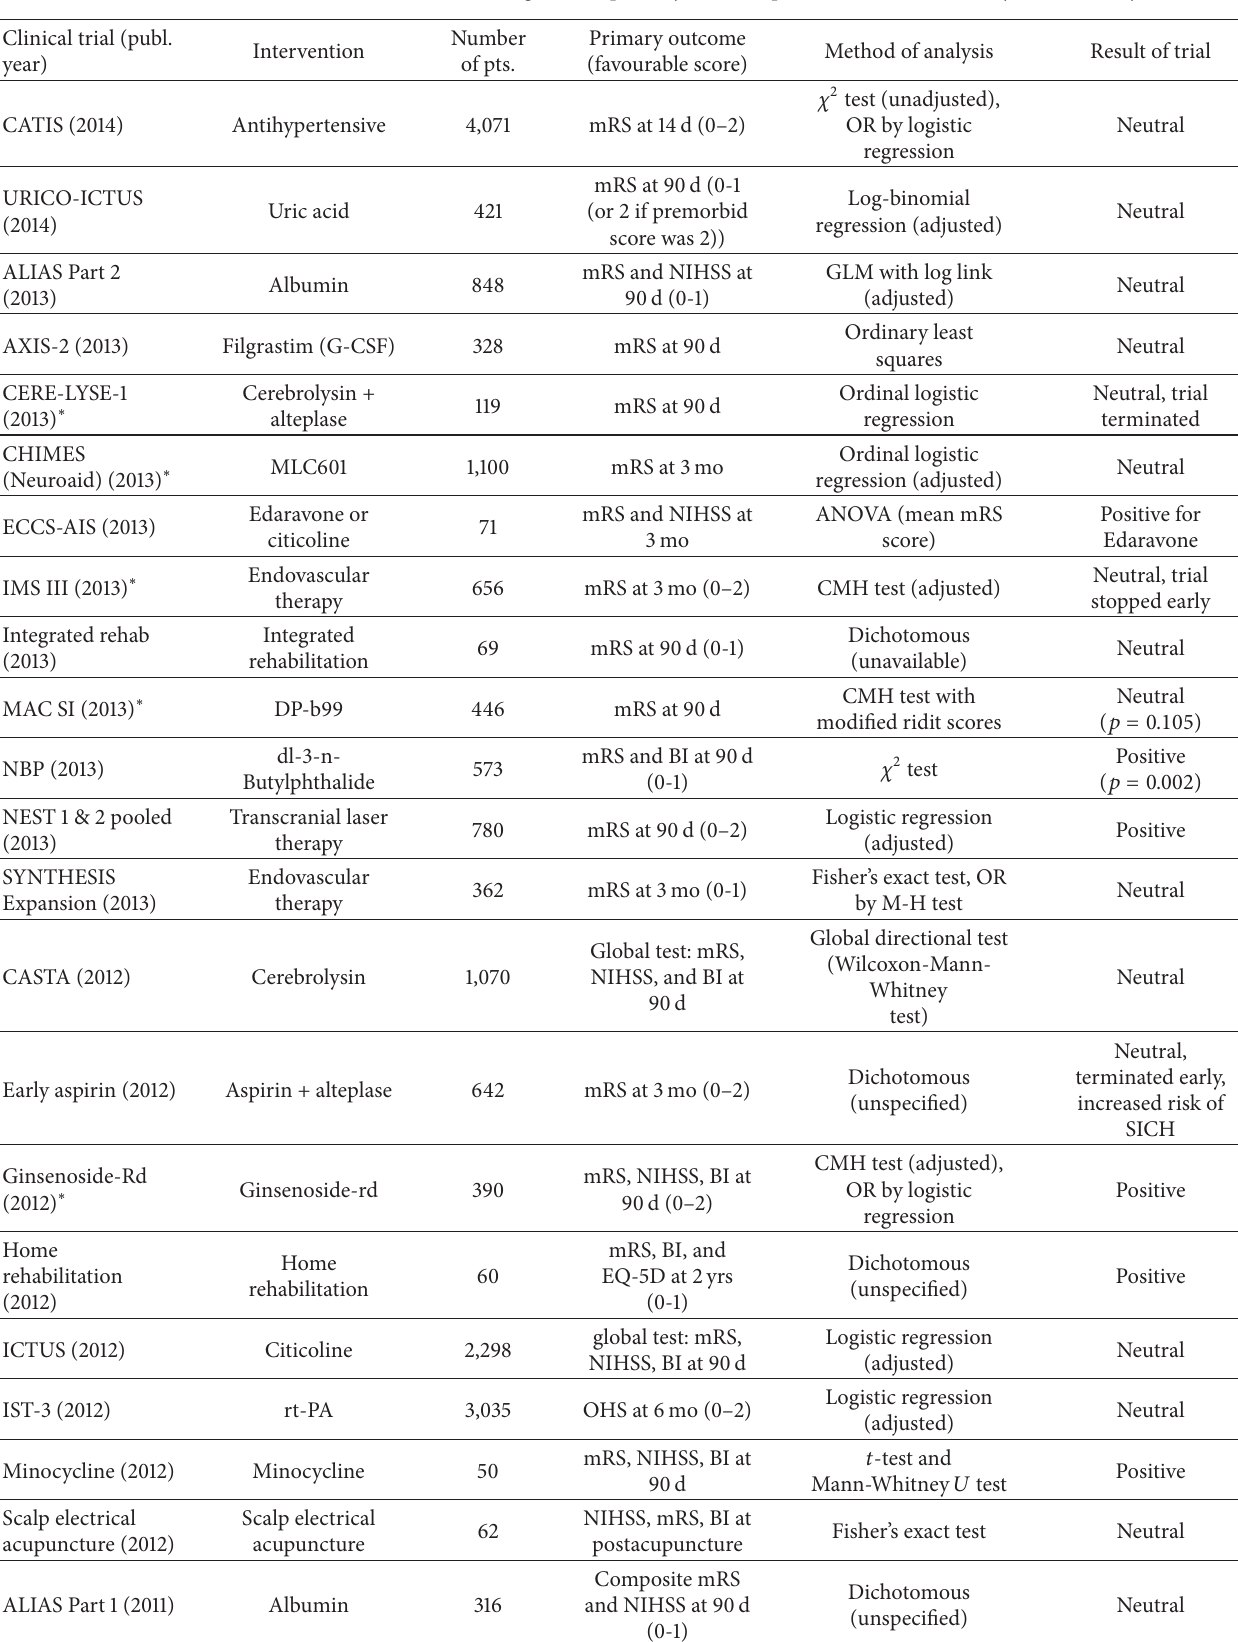
Table 1: Phase III trials in acute ischemic stroke using mRS as primary outcome published between January 2007 and July 2014. Clinical trial